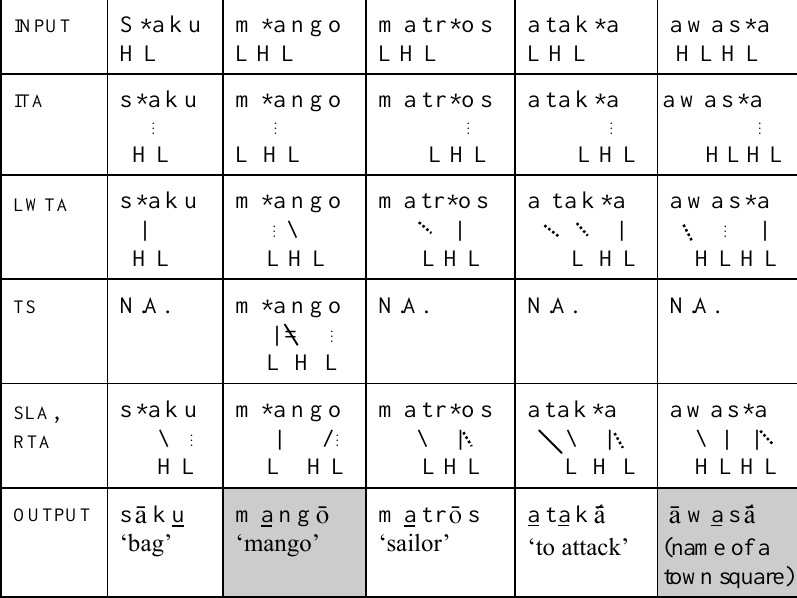
Table 3. Derivation of Pp words, after Römer (1991: